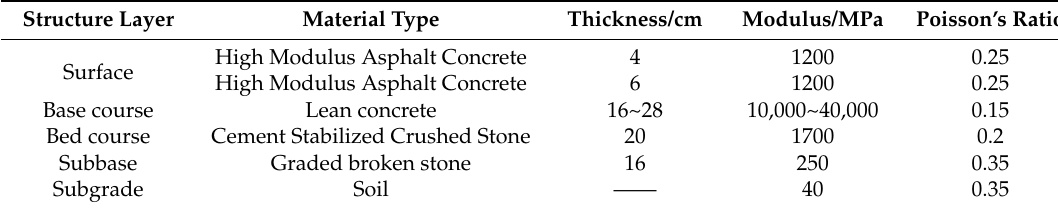
Table 11. Structure and parameters of pavement.